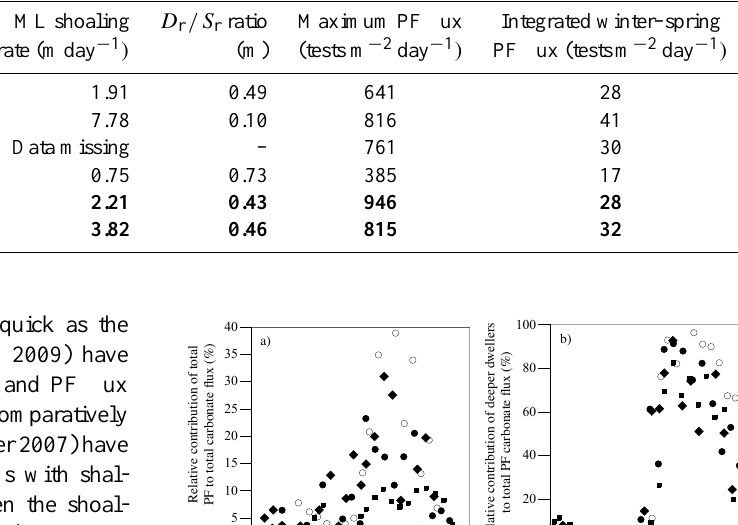
Table 2. Mixed layer depth and mean rates of mixed layer (ML) deepening and shoaling. The D r /S r ratio is a derived value calculated from the rate of ML deepening divided by the rate of ML shoaling (see text). The winter–spring PF flux represents the PF flux integrated over the whole bloom, which varied interannually in length but ranged from December to May. Bold faced years indicate years when a cyclonic eddy was present during the spring bloom period.